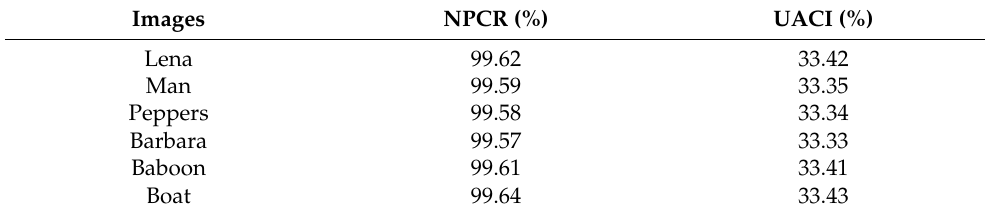
Table 2. NPCR and UACI test results for different test images.